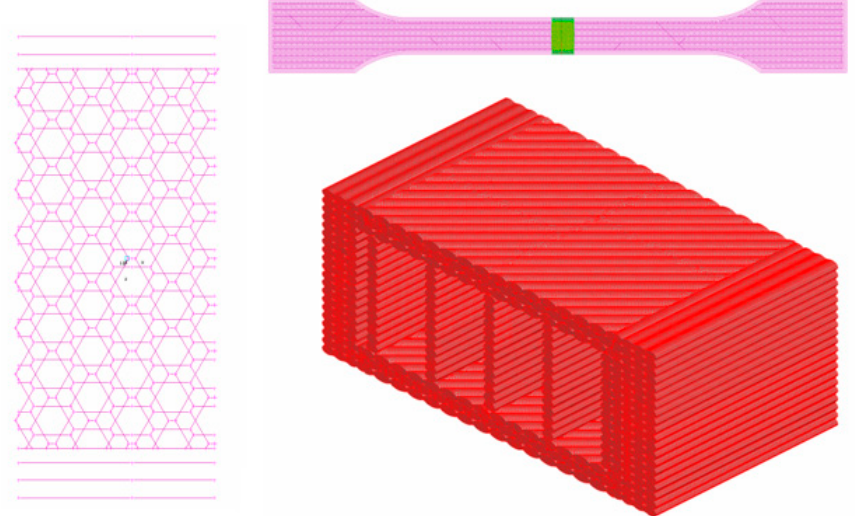
Figure 10. FEM representation of the filaments. (Segment from a standard tensile test specimen).